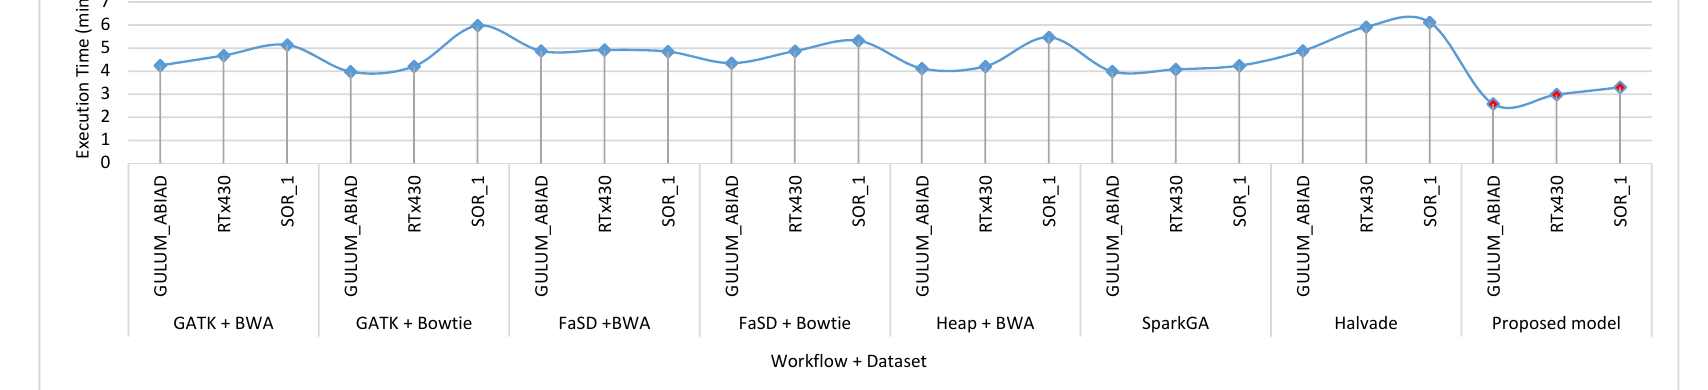
Figure 7. The execution time analysis of single node pseudo cluster, 8 nodes, 16 nodes, and 32 nodes real clusters are shown in part ( a – d ) respectively for Sorghum datasets. The light blue filled circle markers over the line show the values for existing workflows and the solid red filled circle shows the values for the proposed workflow. Here, it is clear that the proposed workflow takes less time in execution for detecting SNPs as compared to others. It is worth noting that on a larger dataset the efficiency of the proposed framework is much better than a smaller dataset.